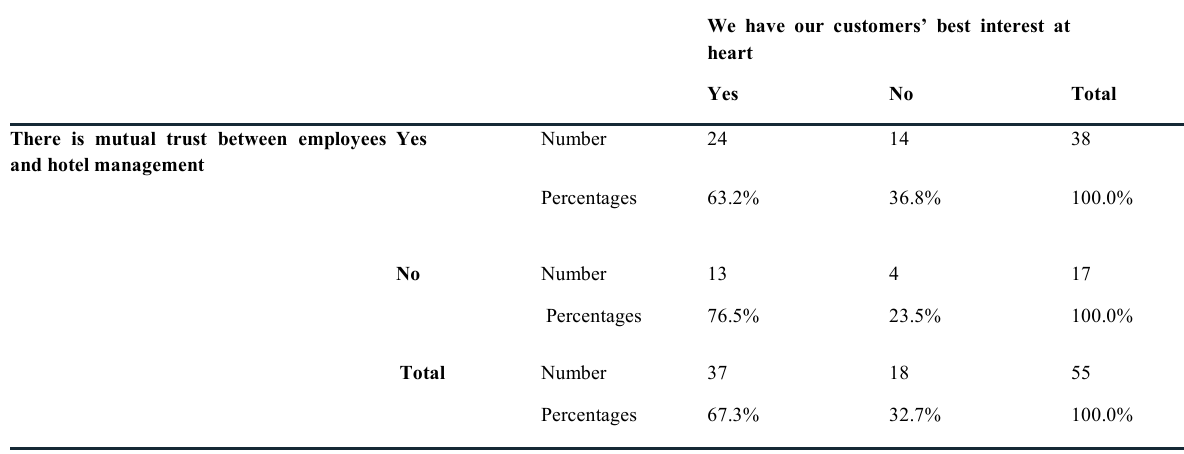
Table 3: Relationship between trust and